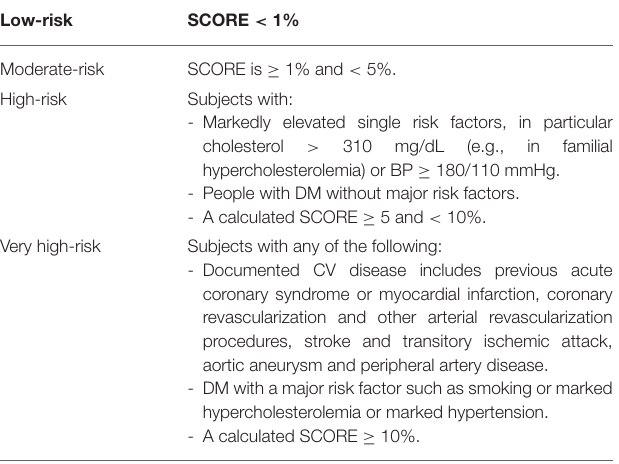
TABLE 1 | Cardiovascular 10-year-mortality risk groups based on the 2016 ESC guidelines on cardiovascular disease prevention (11). Low-risk